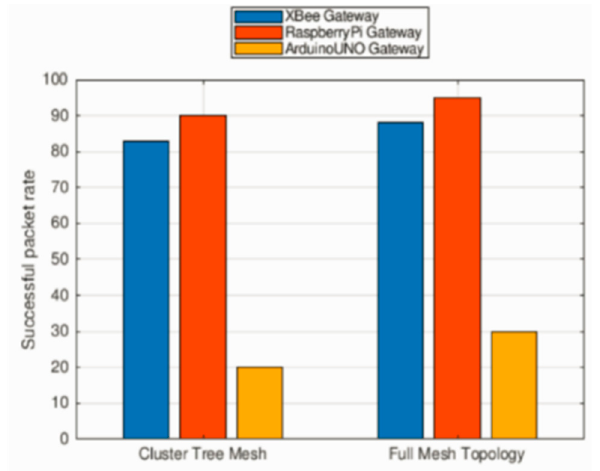
Figure 6. Packet arrival rate using the different gateways under full mesh topology and cluster tree mesh topology.